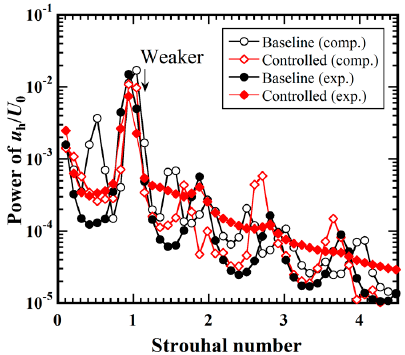
Figure 17. Predicted power spectra of velocity, u h , with and without control at the peak of maximum power for y / θ = 6.4 and 3.6 at x / L = 0.5 and z = z pa , with and without control, respectively. The measured spectra at the peak of maximum power for y / θ = 5.7 and 2.8 at the same streamwise and spanwise positions of x / L = 0.5 and z = z pa with and without control, respectively, are also shown.